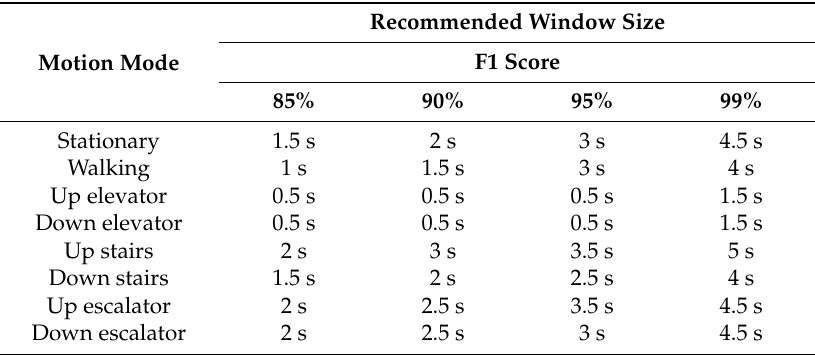
Figure 7. Relationship between F1 score and window length (horizontal axis) for different motion modes. Table 5. Recommended window size for specific motion mode classification.